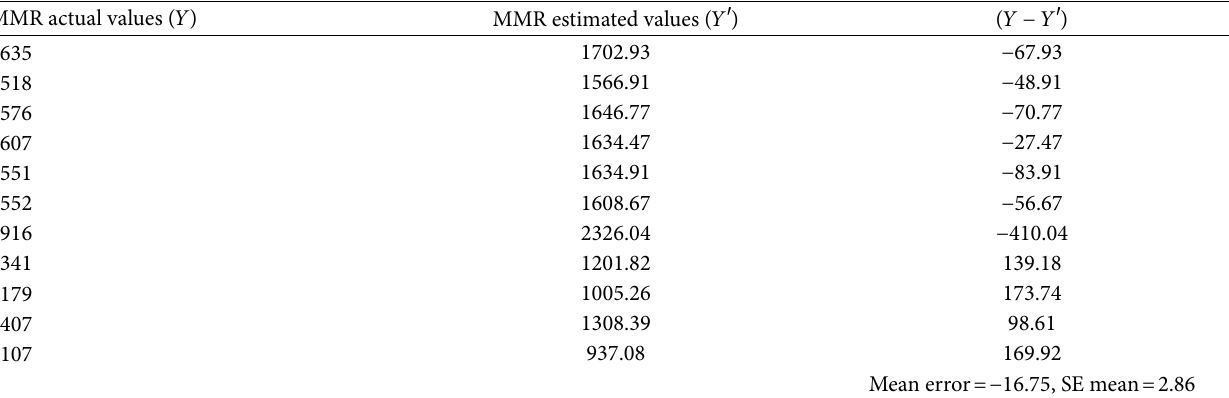
Table 6: MMR predicted values vs. actual values for reduced Poisson model (8) and the mean error. MMR actual values ( 𝑌